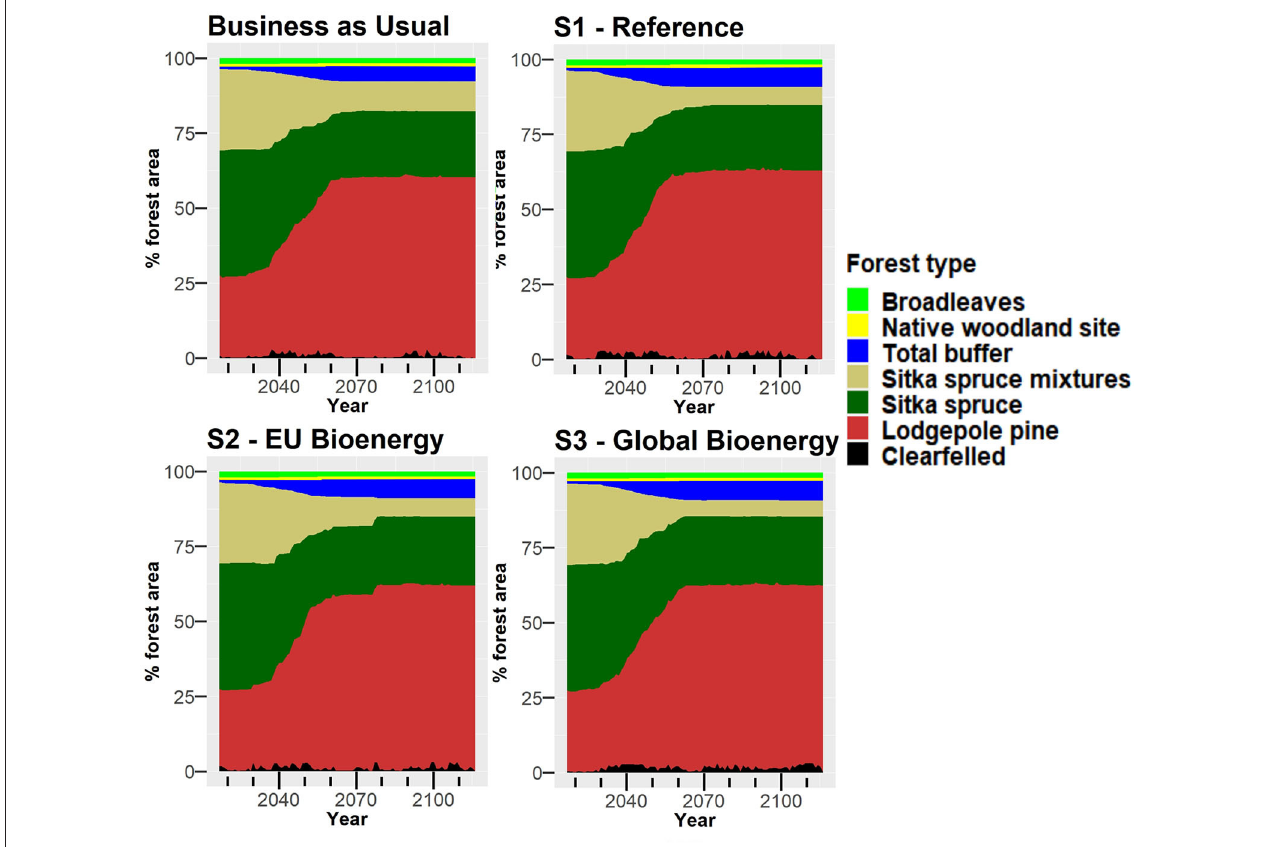
FIGURE 2 | Percentage area by forest type for the four scenarios over the planning horizon. The Broadleaves group contains managed broadleaf forests. Native Woodland Sites are mainly unmanaged native broadleaf stands retained for their high biodiversity values. Sitka spruce mixtures contain all stands dominated by non-lodgepole pine conifers (including Sitka spruce), with broadleaves and/or non-lodgepole pine conifers as secondary or tertiary species. The Sitka spruce and lodgepole pine groups refers to monoculture stands of the respective species. Source: Lundholm et al.